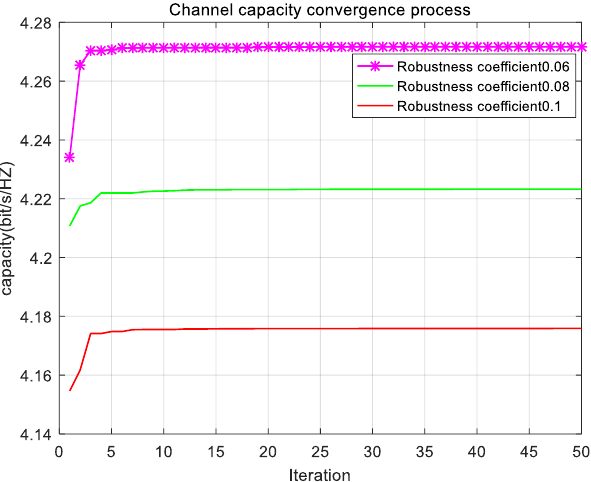
Figure 4. Convergence of channel capacity under different robust coefficients.